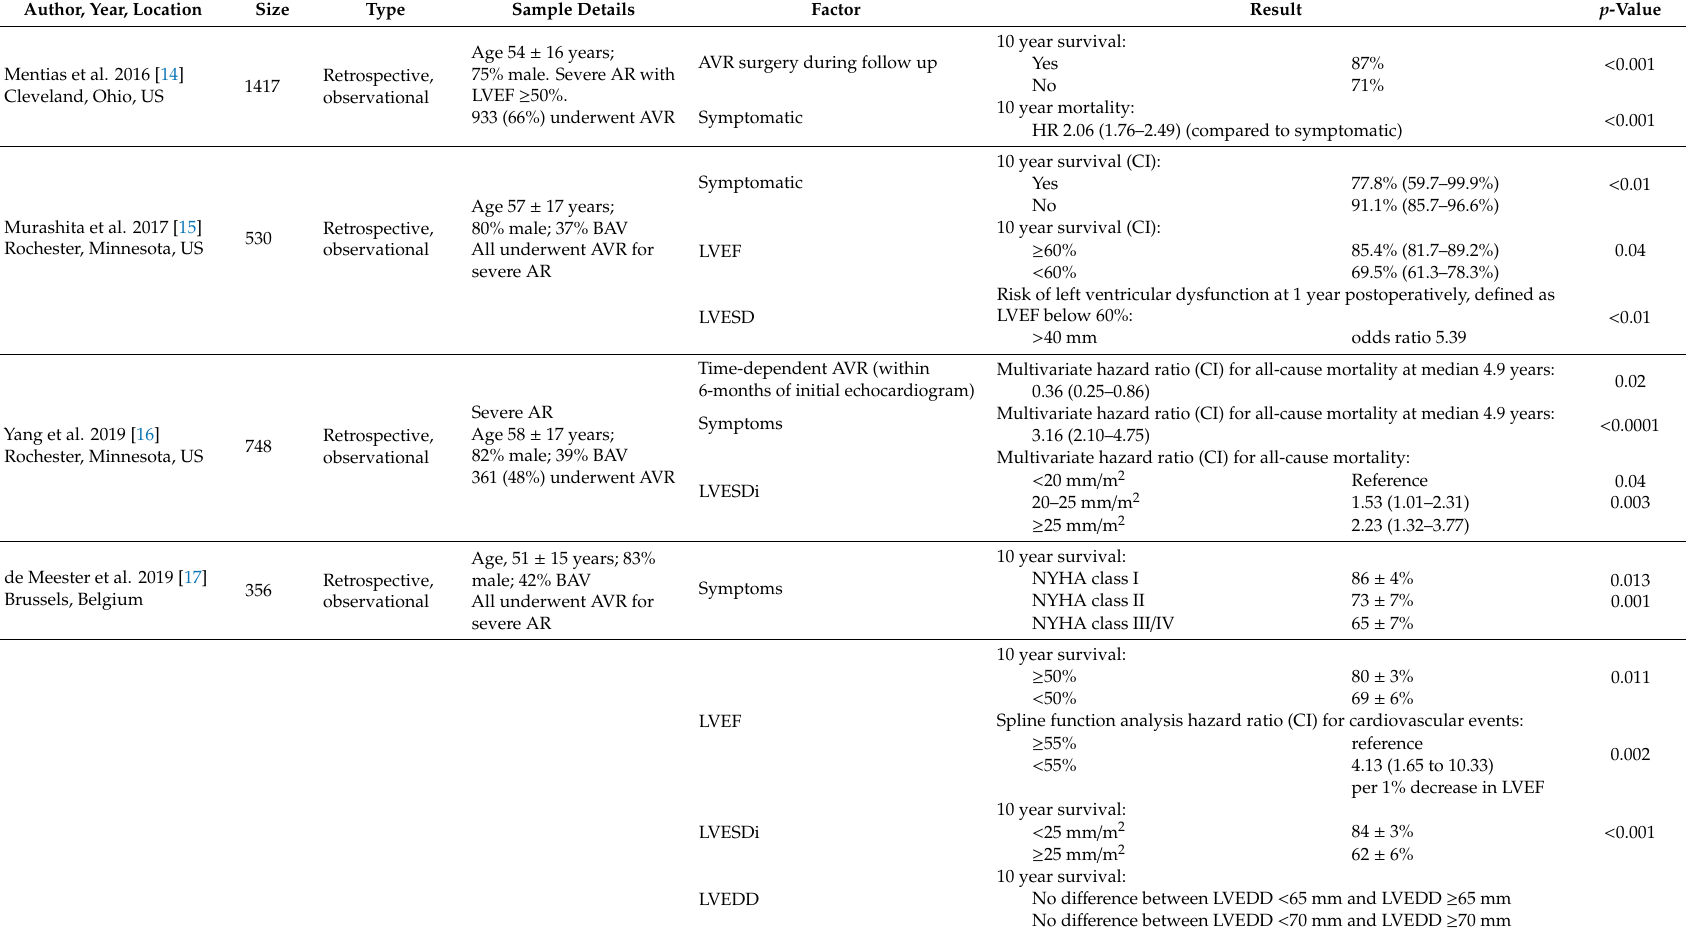
Table 3. Summary of studies that examine the timing of aortic valve surgery for chronic AR which were published subsequent to the release of the AHA / ACC 2014